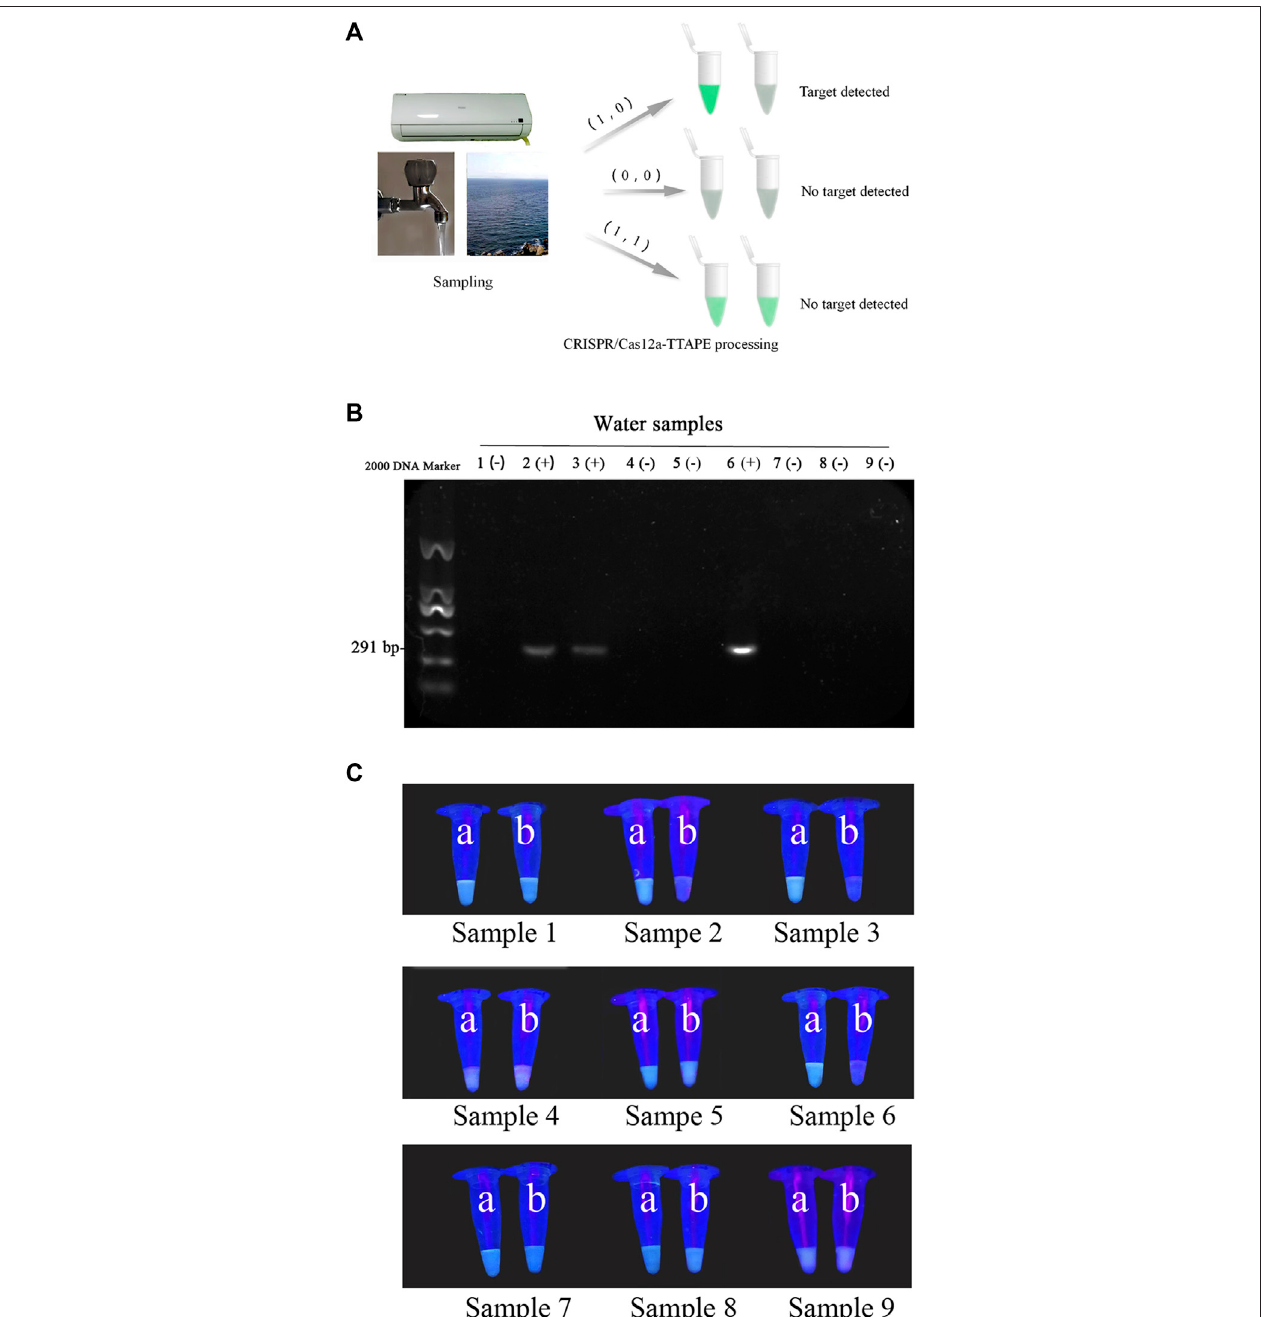
FIGURE 4 | (A) Diagram of the TTAPE-CRISPR/Cas12a platform for detecting environmental water samples; Gel electrophoresis diagram (B) and the visual discrimination results under UVirradiation (C) of L.pneumophila inenvironmental water samples (The target DNAlength is291bp. “ + ” representssamplescontaining L. pneumophila , “ − ” represents samples without L. pneumophila . 1 – 3: air-conditioned water samples, 4 – 6: lake water samples, 7 – 9: tap water samples; a: +TTAPE, b: +TTAPE +Cas12a-RNP).